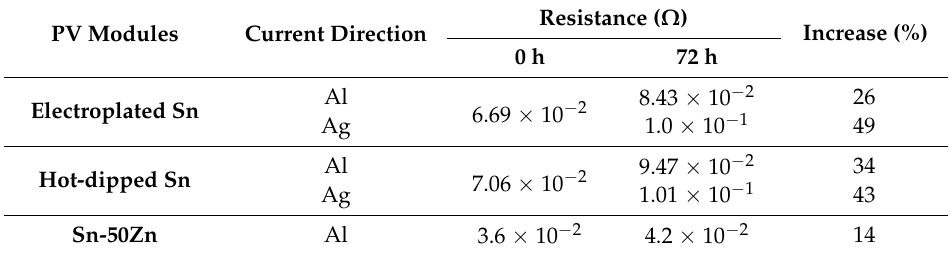
Table 3. Series resistances of Al-ribbon with different coated solders as a function of biased